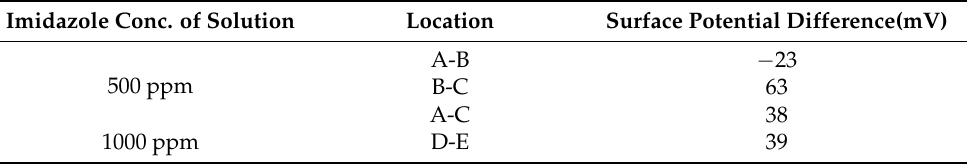
Table 5. Difference of surface potential between distinctive areas in results of AFM